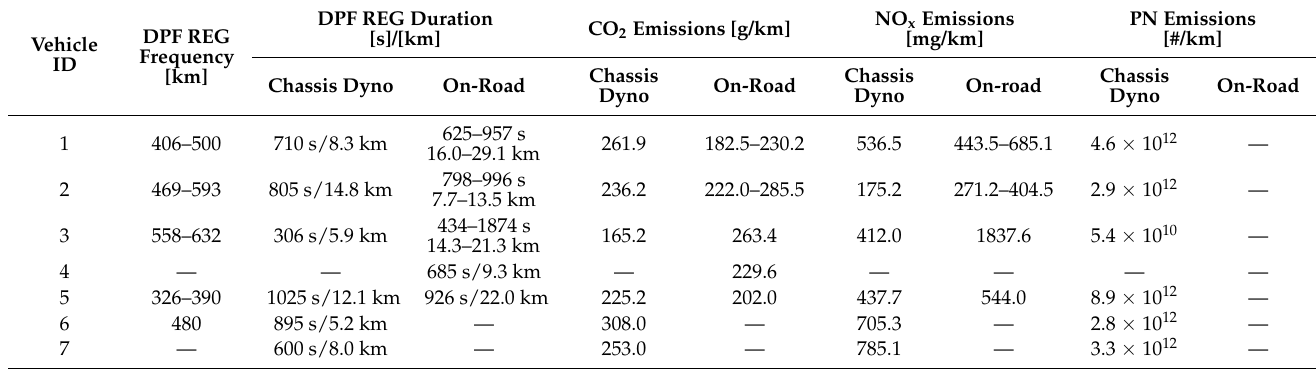
Table A4. Actual CO 2 , NO x and PN emissions during the DPF regeneration period only.